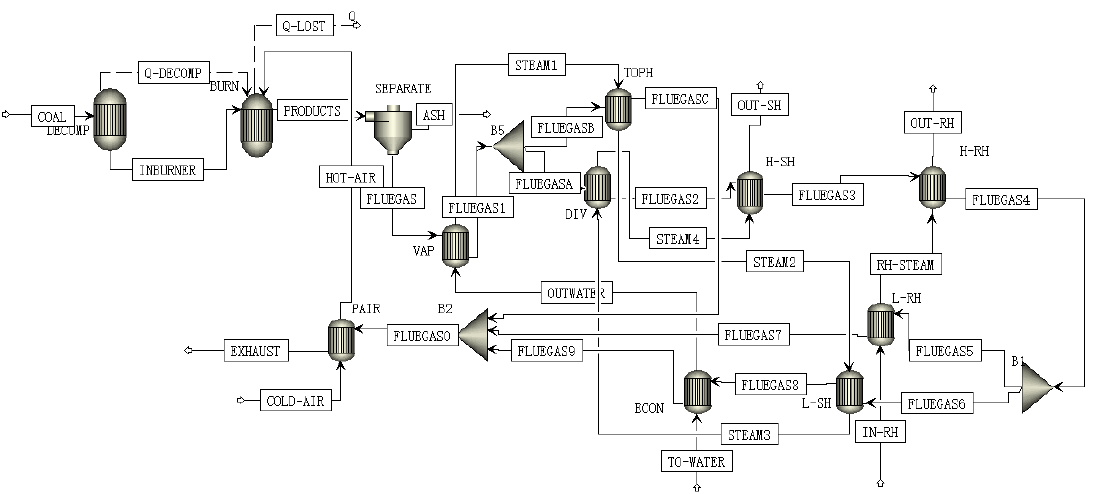
Figure 7. General diagram of boiler system model. Table 5. Input parameter settings of model.